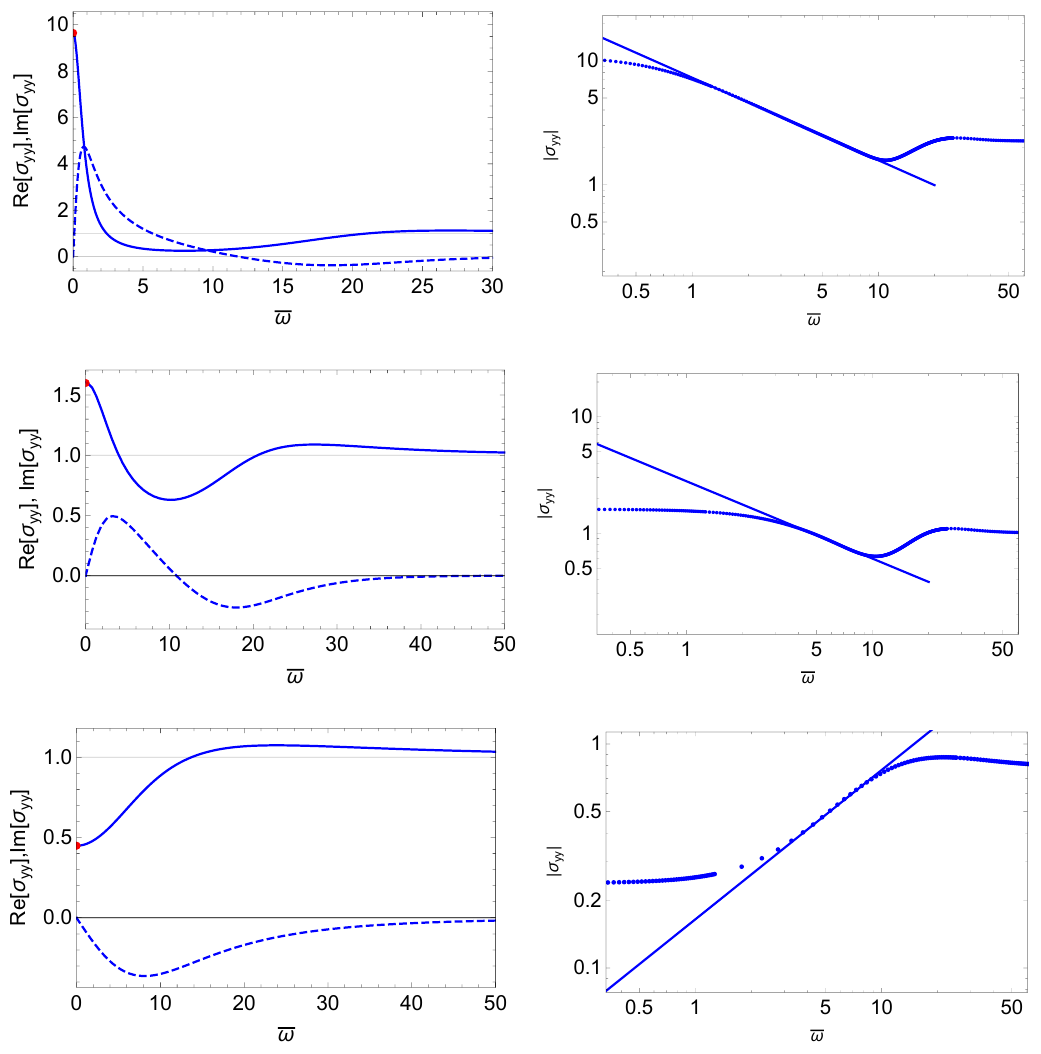
Figure 3 . Left column: the real (solid) and imaginary (dashed) parts of the AC conductivities (cid:27) yy in terms of frequency ! , for k 2 = 0 : 4 (top), 2 (middle) and 4 : 8295 (bottom), where we take p 1 = 1 and k 1 = 0 : 1 and used (cid:22) ! = !=T . Right column: the Log-Log plots for j (cid:27) yy j (cid:24) (cid:22) ! (cid:0) (cid:11) , where p j (cid:27) yy j = Re[ (cid:27) yy ] 2 + Im[ (cid:27) yy ] 2 , and from top to down, (cid:11) ’ 2 = 3 ; 2 = 3 ; (cid:0) 2 = 3,